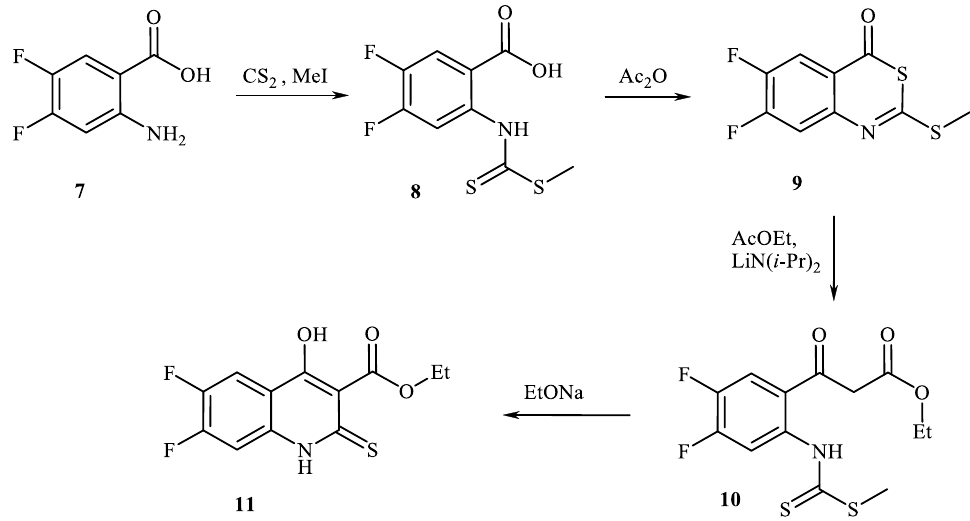
Scheme 2. Synthesis of 6,7-difluoro-4-hydroxy-2-thioxo-1.2-dihydroquinoline-3-carboxylate